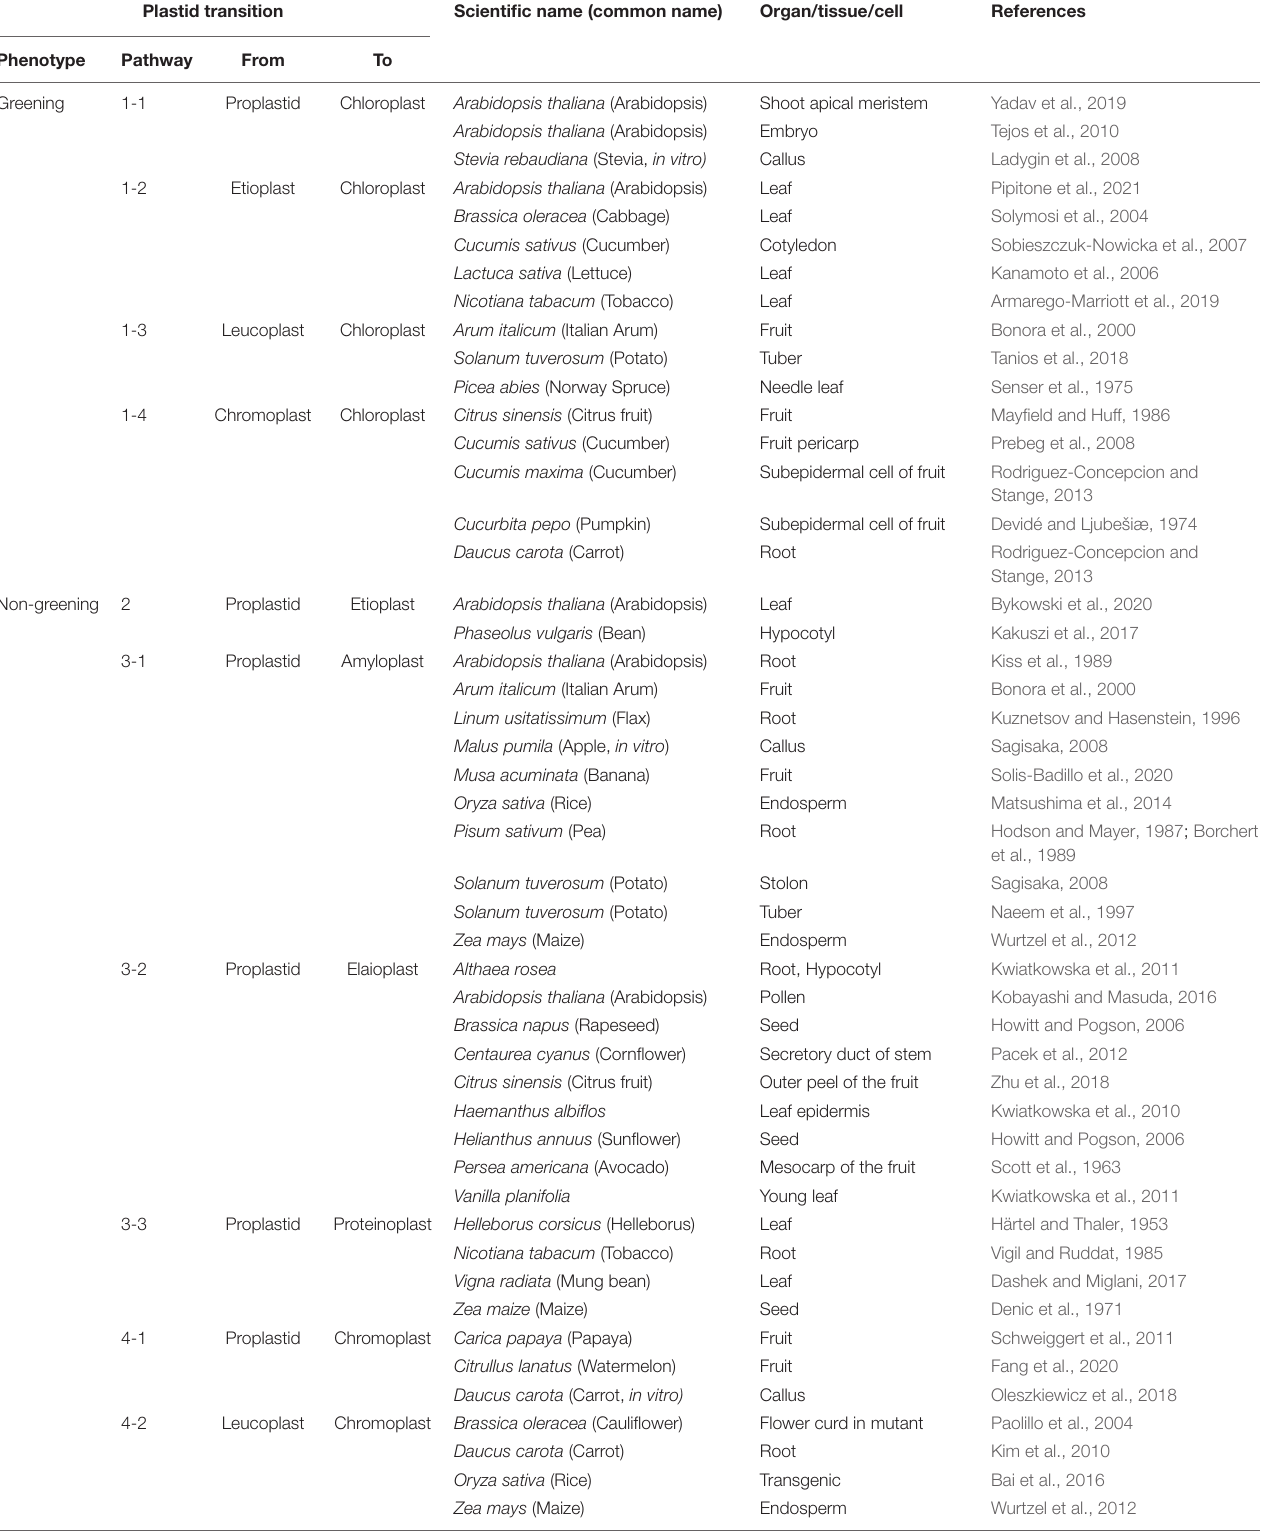
TABLE 1 | Plastid transitions according to plant phenotypes in the view of greening status. Plastid